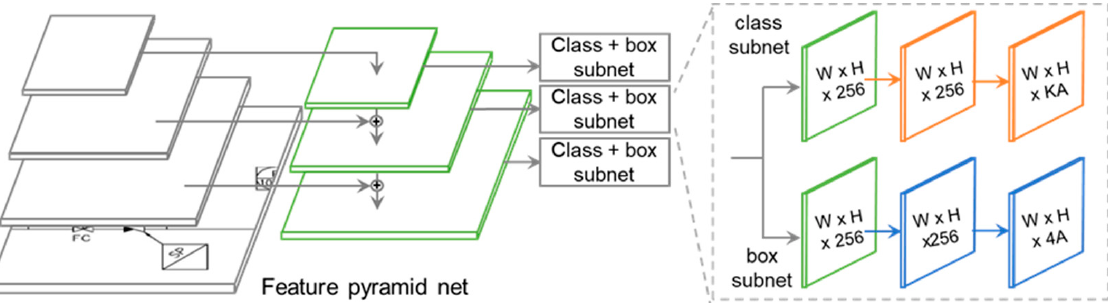
Figure 15. The architecture of RetinaNet [23].